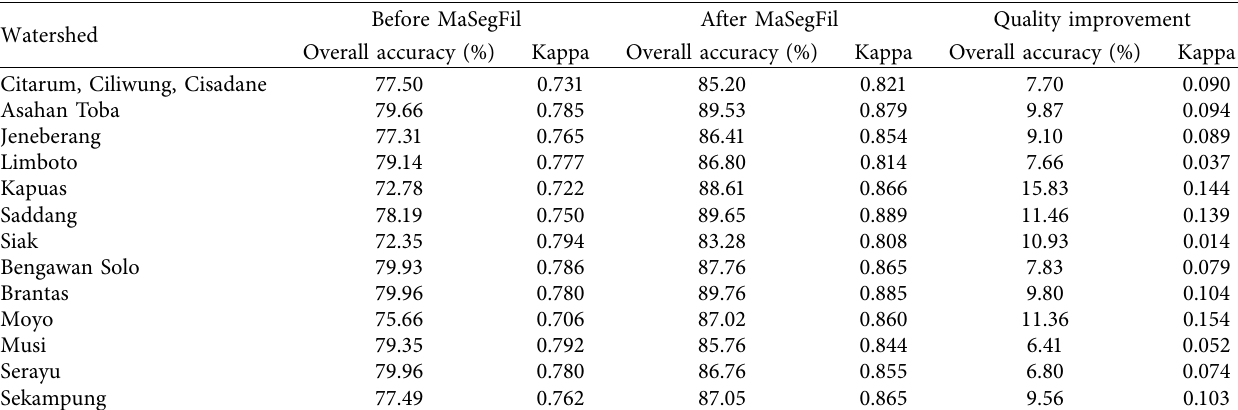
Table 8: Results of the LULC classification accuracy assessment based on the RF classifier before and after using the MaSegFil approach. Before MaSegFil After MaSegFil Quality Watershed